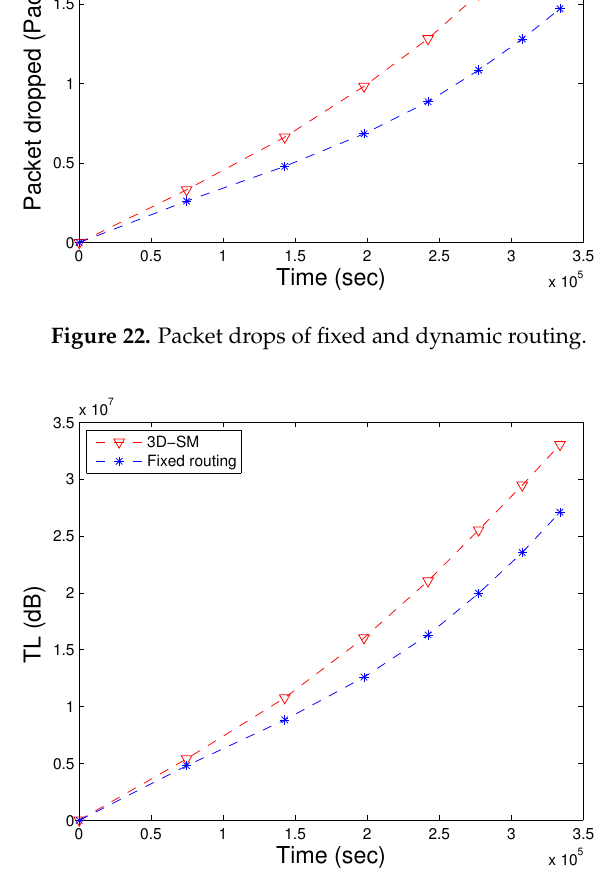
Figure 23. Transmission loss of fixed and dynamic